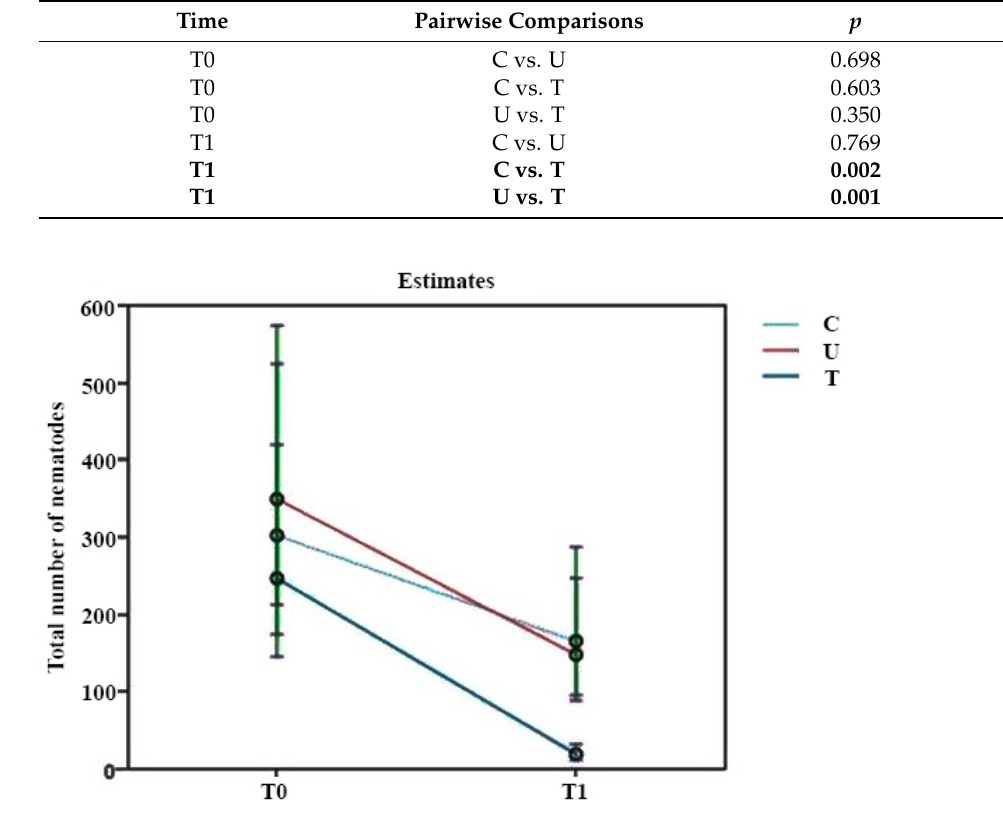
(Figure 3). Effect size: d = 0.20 (T vs. U) and d = 0.16 (T vs.